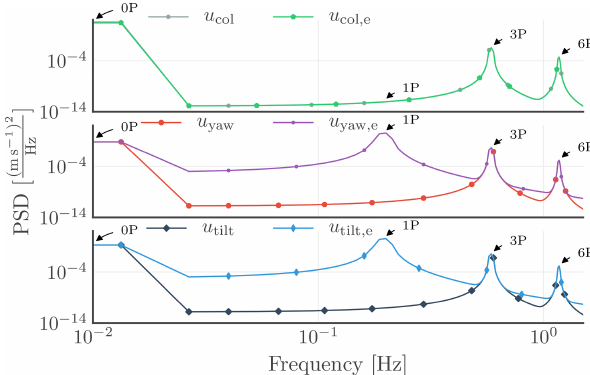
Figure 8. Power spectral densities of collective, yaw, and tilt com- ponents of the generic signals with partial DC offset. The expres- sion u ..., e indicates the case where the DC offset ( u 0 in Eq. 22) of one of the signals differs from the other two in the rotating frame of reference.